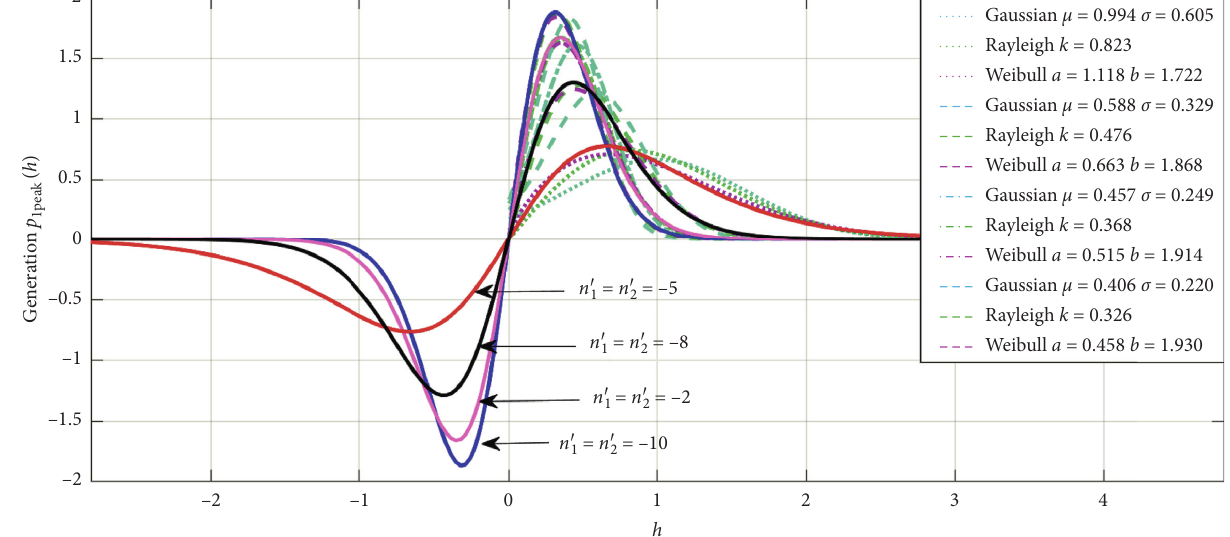
Figure 20: Generalized peak PDFs of AHTNPS except the difference in n